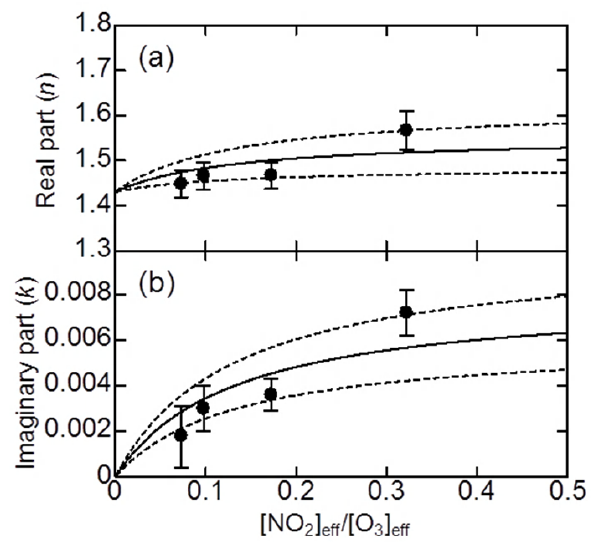
Figure 8. [NO 2 ] eff /[O 3 ] eff dependence of the (a) real and (b) imaginary parts of the RI values at 405 nm for the toluene-SOAs. The solid and dashed lines are the best estimation and upper (or lower) limit values, respectively, calculated using eqs. (5) and (6) assuming a constant [NO] eff /[NO 2 ] eff (=0.04); see text.